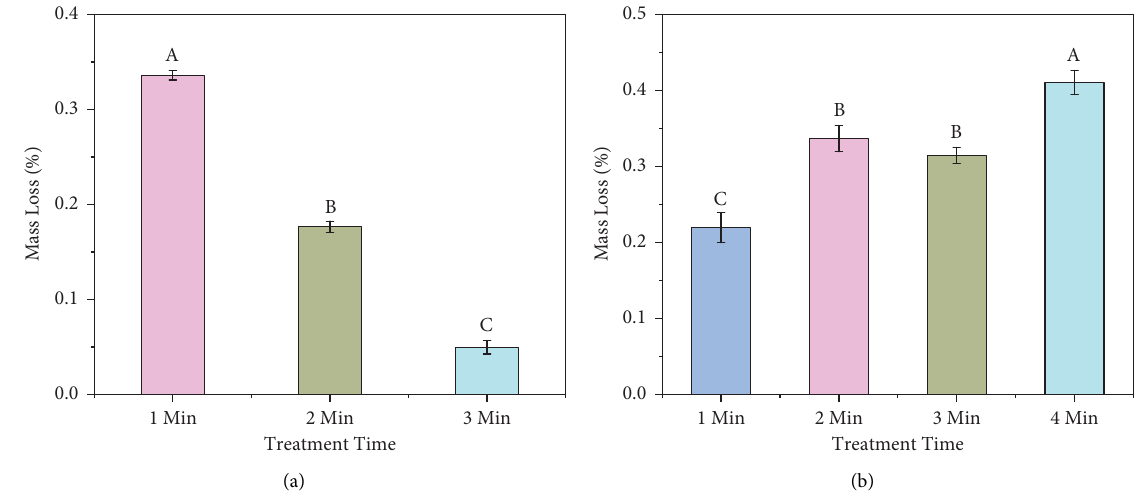
Figure 18: Estimation of mass loss in (a) radish and (b) carrot seeds due to CAPP exposure.